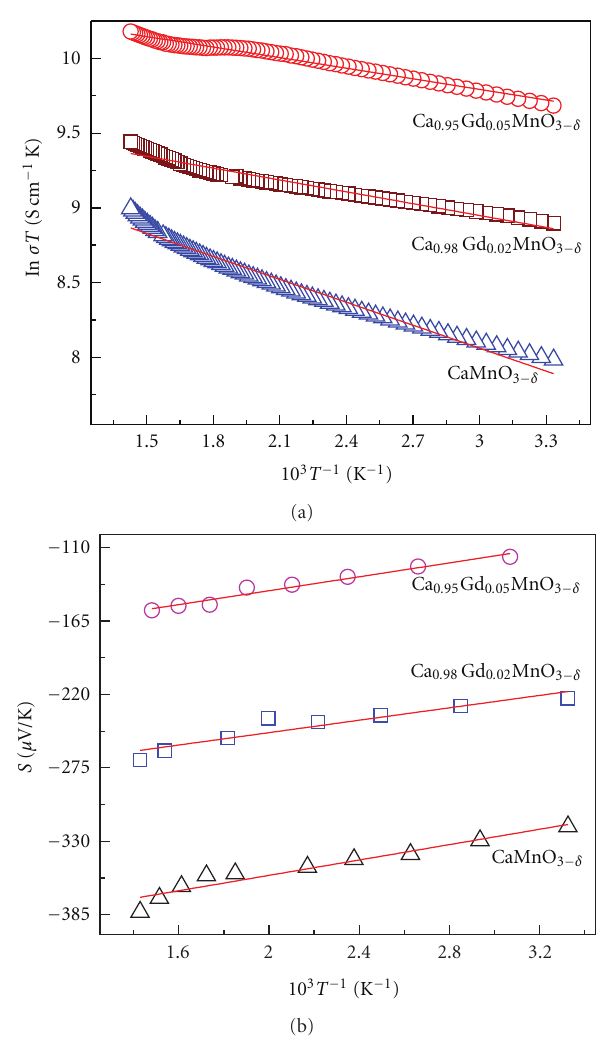
Figure 4: Plots of (a) In ( σ T ) versus 1000/T and (b) S versus 1000/T of the Ca 1 − x Gd x MnO 3 − δ (0.00, 0.02, and